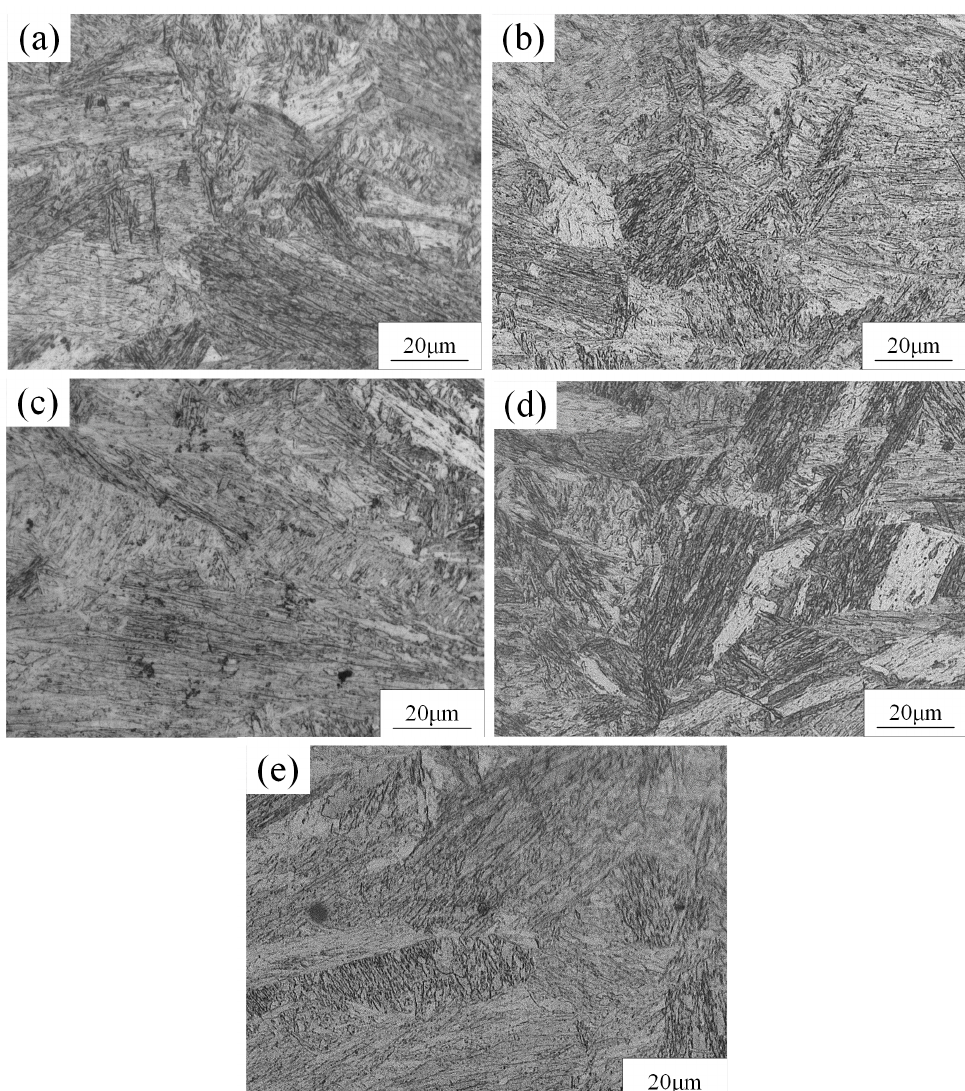
Figure 9. The microstructure of FZ of DP 780 laser-welded joint under different laser powers (W): ( a ) 2400, ( b ) 3000, ( c ) 3600, ( d ) 4200, and ( e ) 4800.